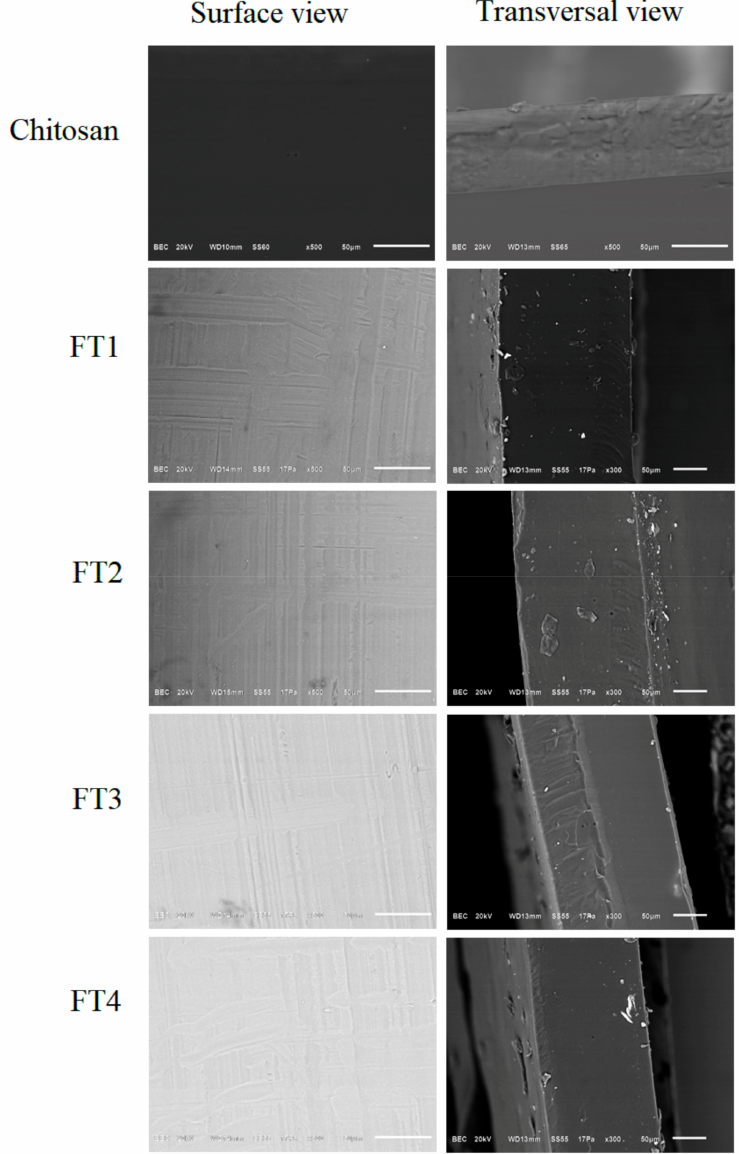
Figure 7. SEM micrographs of the surface and the inner part of the hybrid films FT1–FT4 containing different concentrations of TvEO (0.4–1.3%). The features of films made with pure chitosan are included and the scale bar is equivalent to 50 µ